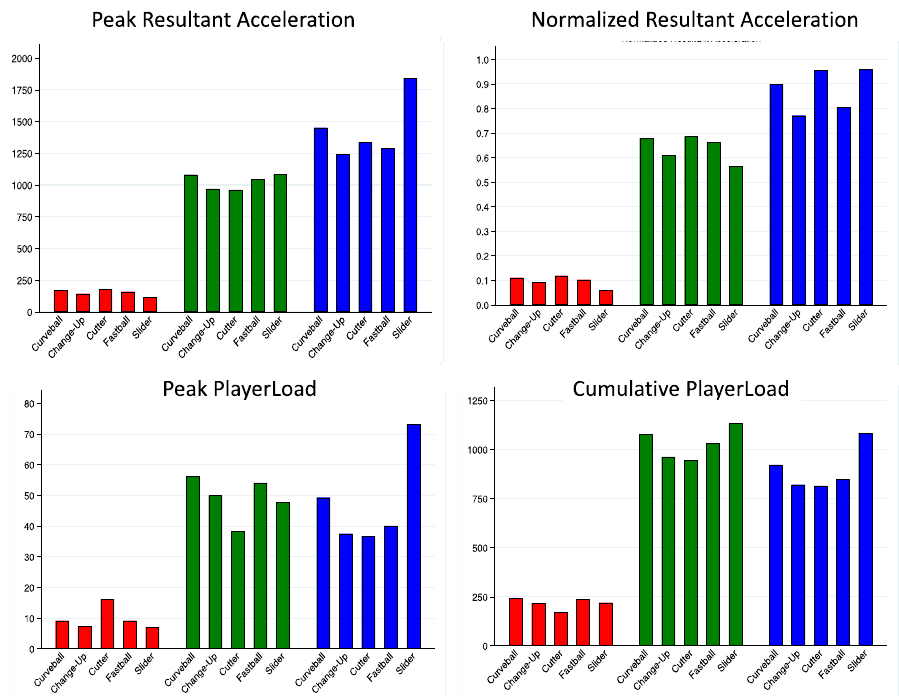
Figure 2. Mean workload estimates across pitch type and sensor location. Red indicates values from sternum sensor; Green indicates values from upper arm sensor; and Blue indicates values from forearm sensor. Workload estimates varied by calculation method and did not show the same pattern across pitch types. Table 2. Workload Estimates Across Pitch Types and Sensor Locations. Pitch type included fastballs (n = 184), change-ups (n = 76), curveballs (n = 95), sliders (n = 5), and cutters (n = 6). Peak resultant acceleration is expressed in m/s 2 ; all other estimates are unitless.